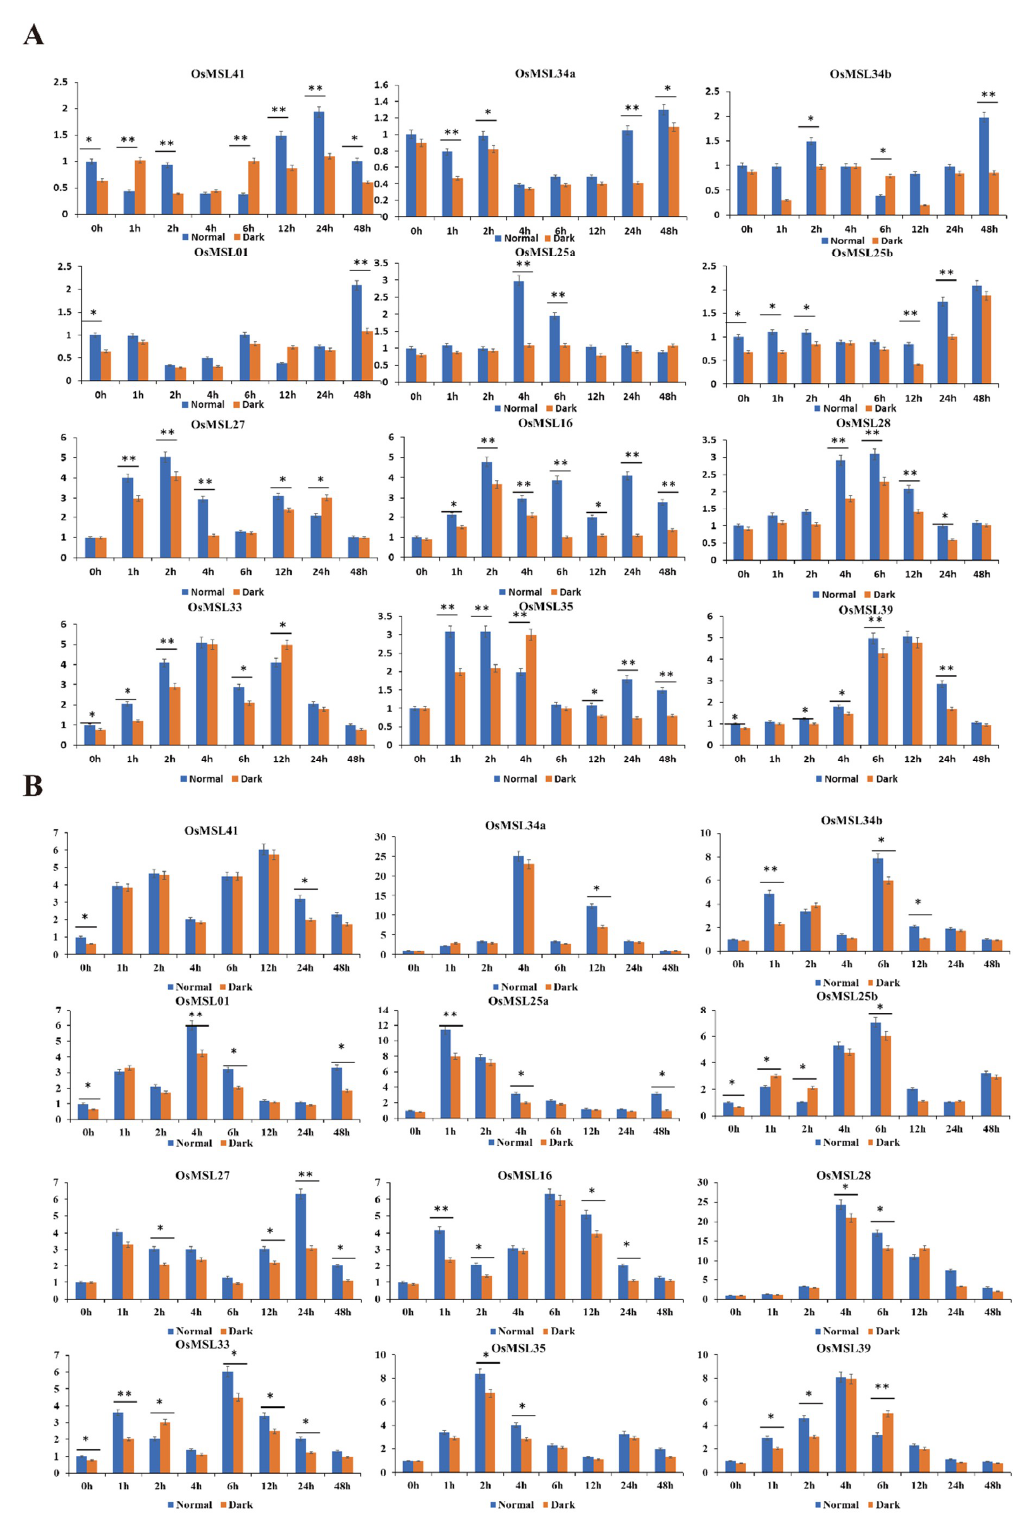
Figure 10. Expression profiles of 12 selected OsMSLs in response to ( A ) ABA (abscisic acid), ( B ) hydrogen peroxide treatments. Data were normalized to the β-actin gene. Vertical bars indicate standard deviations. Asterisks indicate corresponding genes significantly upregulated or downregulated compared with the control. (* p < 0.05; ** p < 0.01; Student’s t